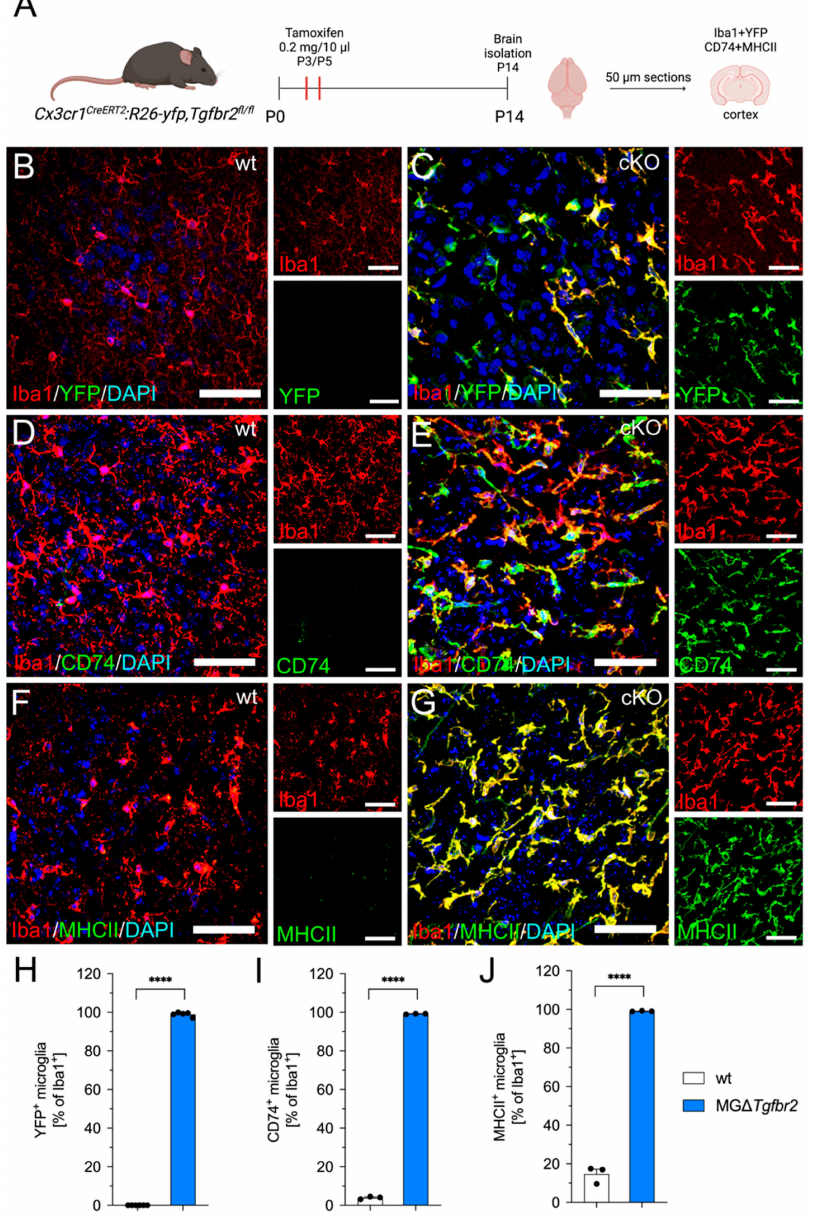
Figure 6. Loss of microglial Tgfbr2 expression results in upregulation of CD74 in vivo. ( A ) Scheme of the experimental workflow for analysis of YFP, CD74, and MHCII expression in frontal cortices of microglia-specific Tgfbr2 mutant mice. Created with BioRender.com. ( B , C ) Immunohistochemistry against for Iba1 (microglia) and YFP (reporter gene) to detect and quantify recombination efficacy. Double staining for Iba1 and CD74 to detect and quantify CD74 + microglia in control ( D ) and knockout mice ( E ). Immunohistochemical detection of MHCII and Iba1 in control mice ( F ) and Tgfbr2 -deficient mice ( G ). Representative images at a magnification of 60 × are shown. Scale bars indicate 50 µ m. Quantifications of YFP + ( H ), CD74 + ( I ), and MHCII + ( J ) microglia in control and mutant mice. Data are given as means ± SEM for at least three mice per group. p -values derived from student’s t -test are shown as follows: **** p <